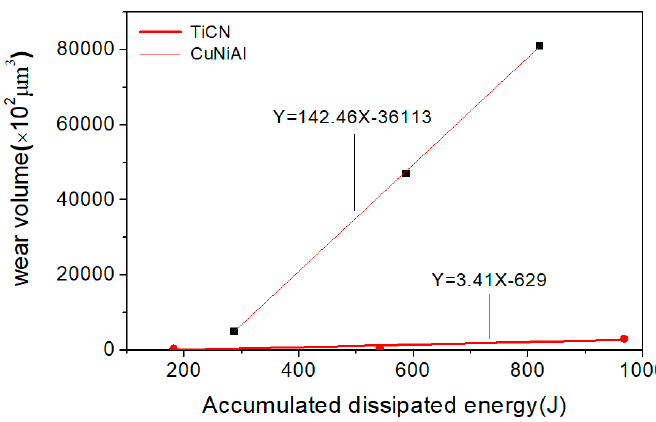
Figure 11. Wear volume vs. accumulated dissipated energy in oil.